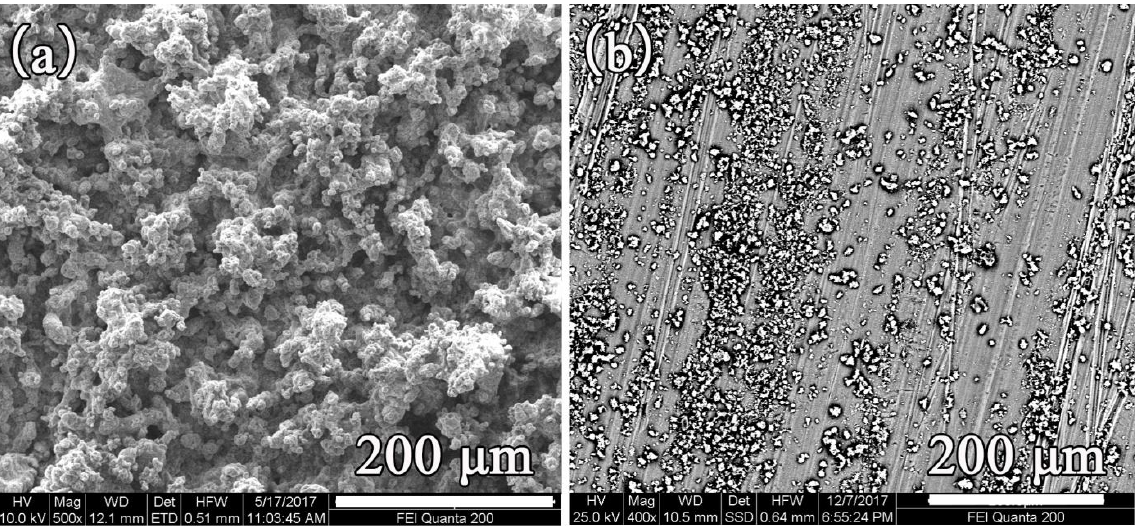
Figure 12. Relationship between the number of frictions and wettability of samples prepared with various mass ratios of resin to ZnO.